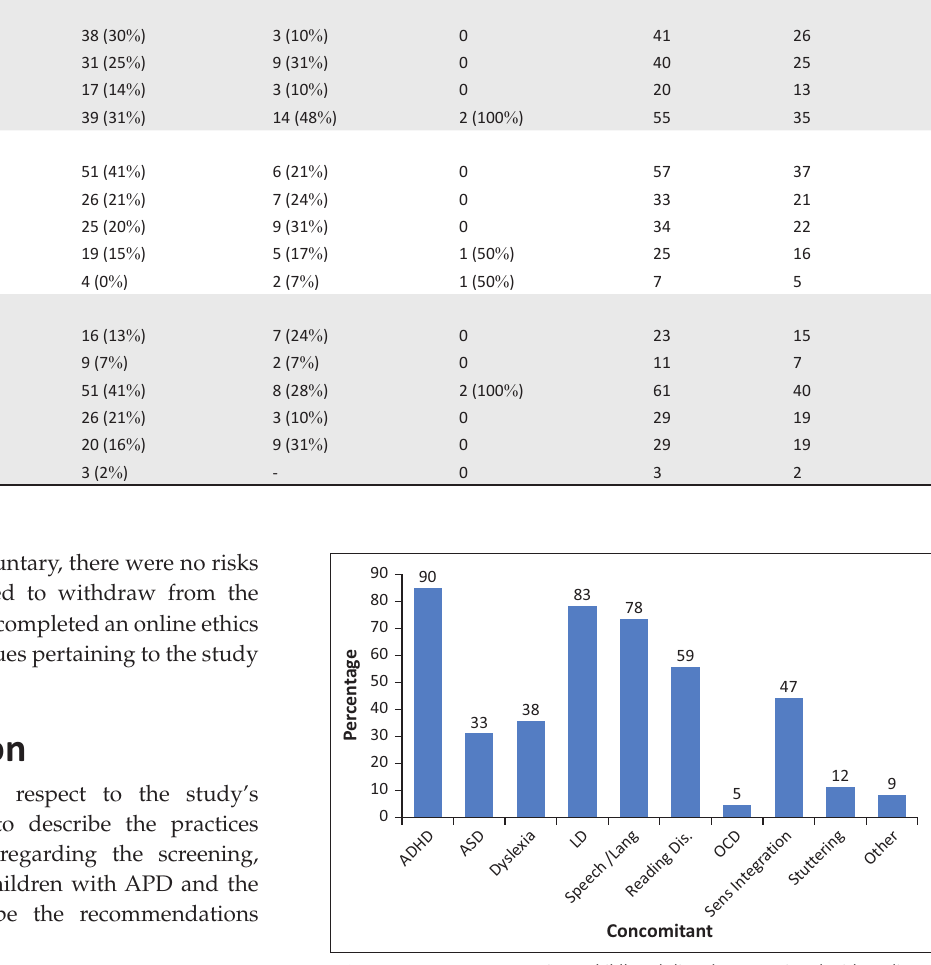
TABLE 1: Demographical profile of study participants. Work experience in years and qualification details